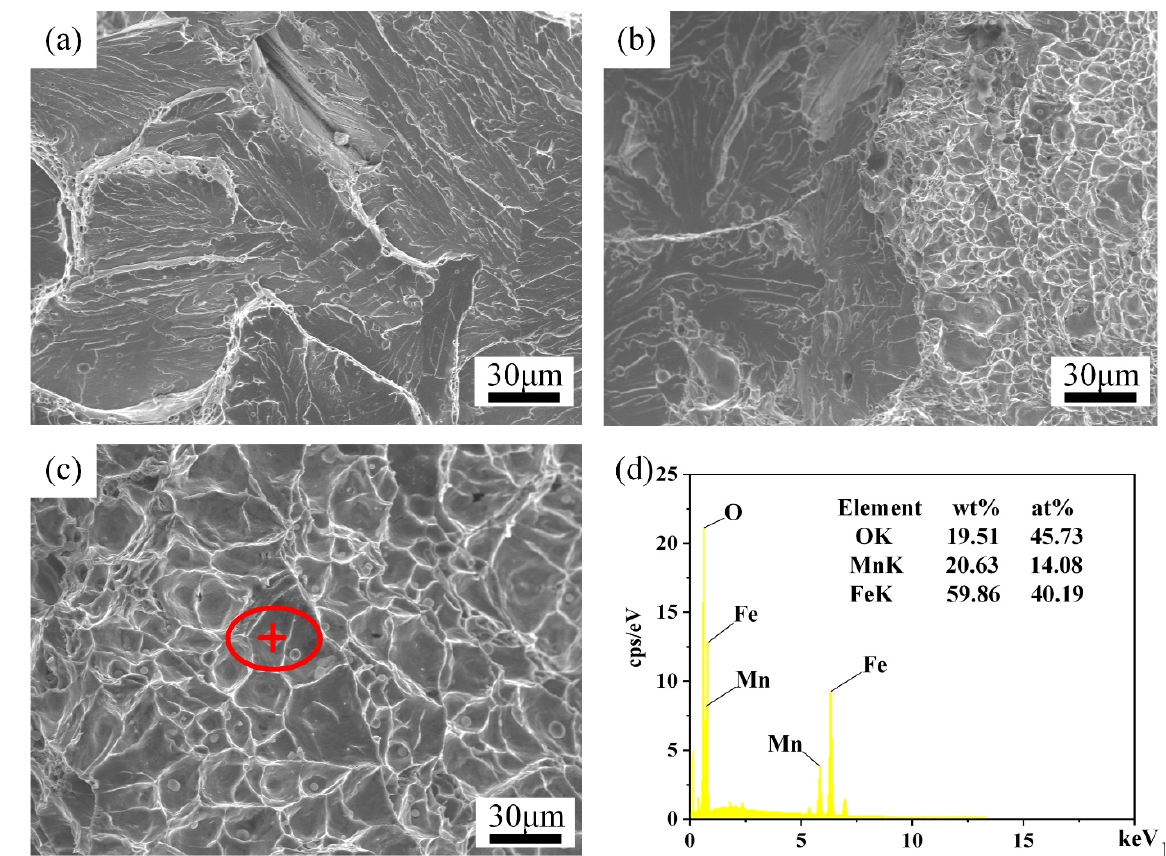
9. SEM fracture of the impact toughness tests. ( a ) UWW, ( b ) WG-USAW and ( c ) EP-USAW ( d ) EDS results of the inclusions.